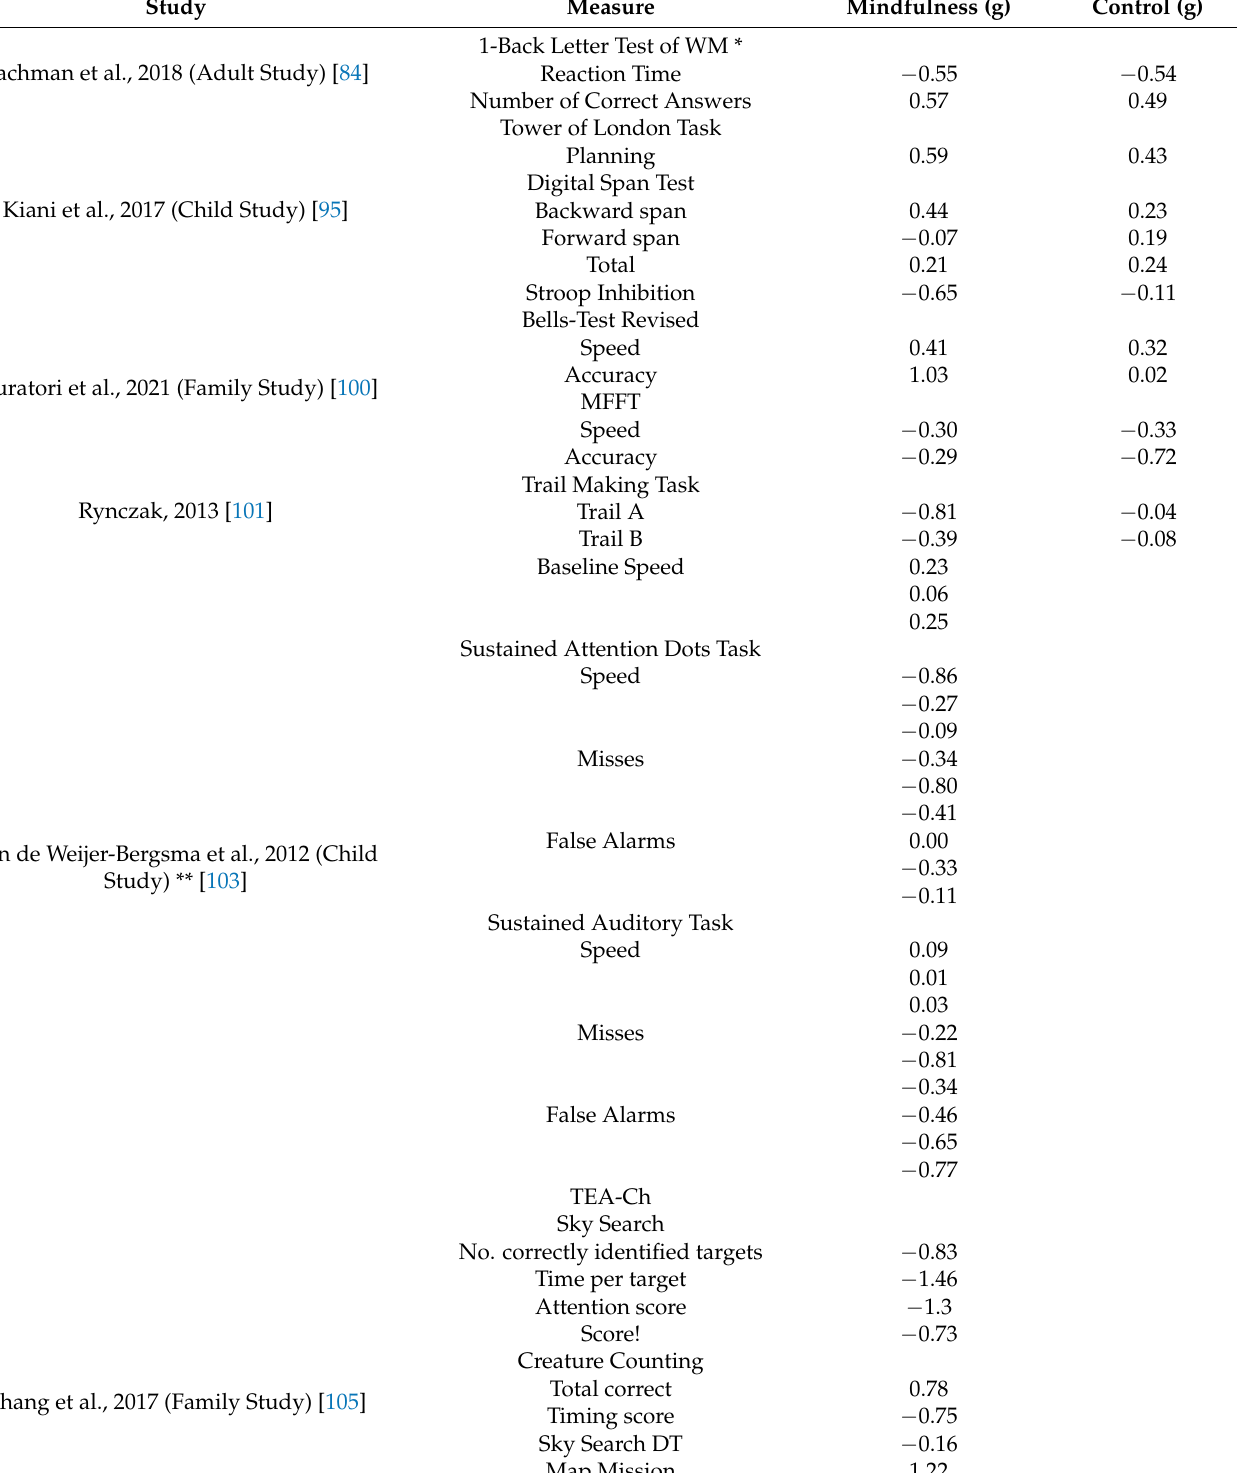
Table 4. The effect sizes from the results of other tests relating to attention and executive function used in single